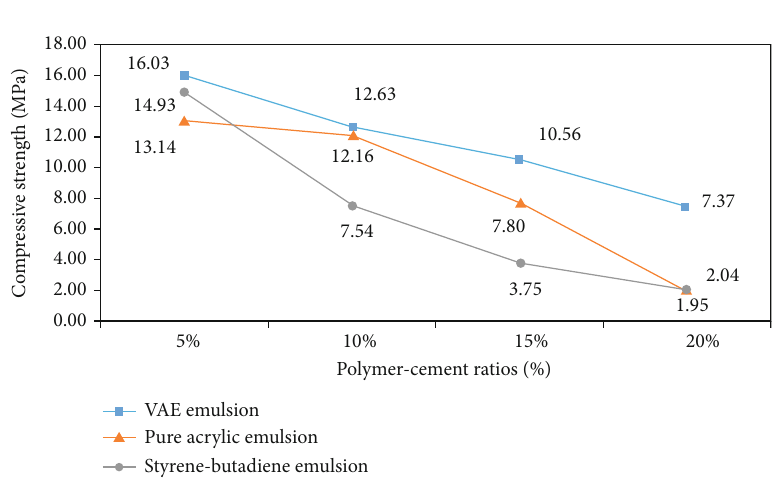
Figure 9: Flexural test data.